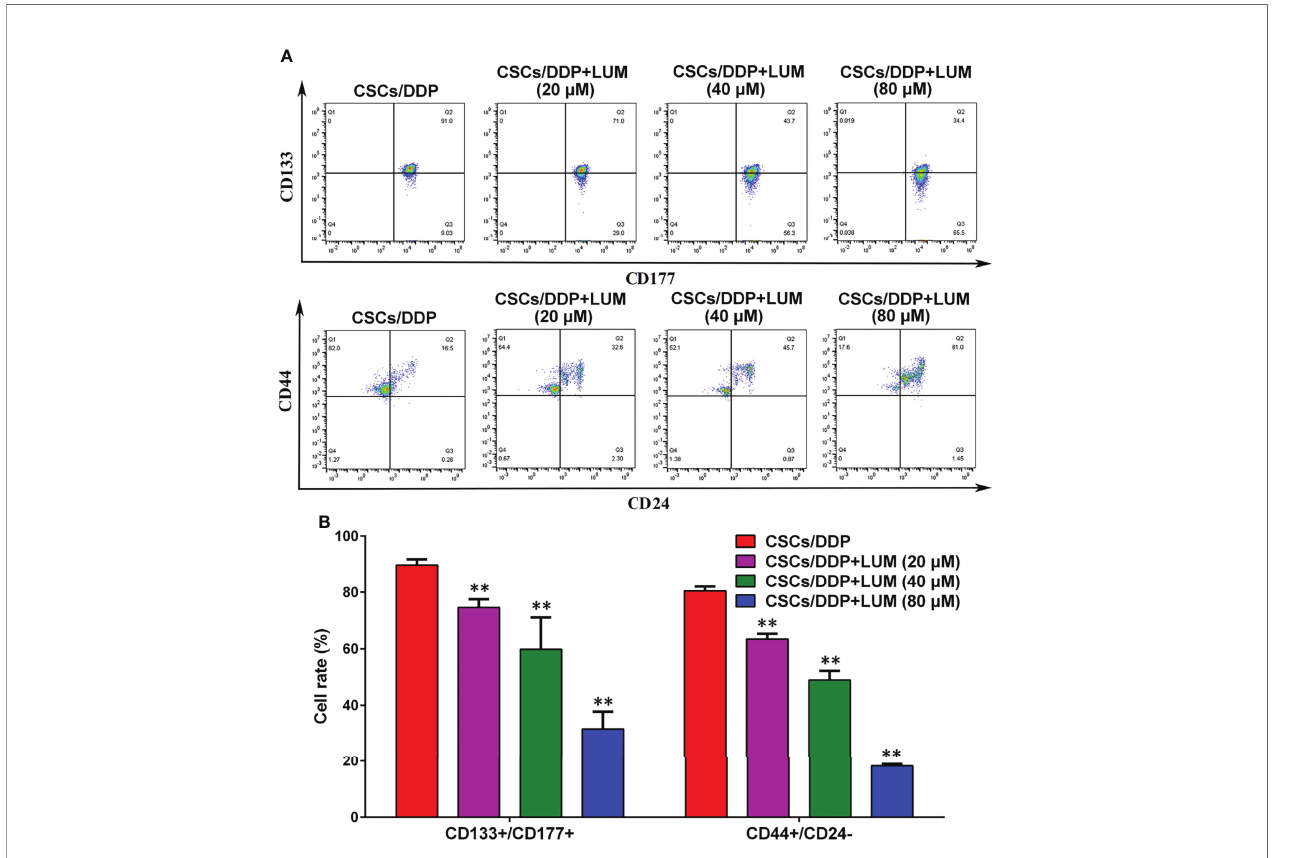
FIGURE 4 | Effects of lumi fl avin treatment on phenotypic differentiation of DDP-resistant cancer stem cells (CSCs/DDP). CSCs, CSCs/DDP were treated with 80 m M DDP, and CSCs/DDP were treated with 80 m M DDP and 20, 40, 80 m M lumi fl avin for 72 h. Co-expression of CD133+/CD117+, CD44+/CD177, and CD44+/CD24 – of CSCs/DDP were detected through fl ow cytometry. (A) Flow detection results of CD133+/CD117+, CD44+/CD177, and CD44+/CD24- cells of CSCs/DDP. (B) Statistical analysis graph of (A) . ** P < 0.01 between groups. Mean ± SD ( n = 3). CSCs/DDP, CSCs from DDP resistant OVCAR-3 cell lines; LUM, lumi fl